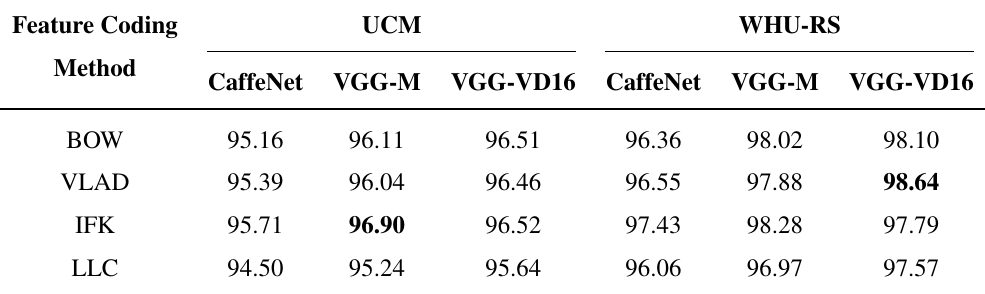
Table 4. Overall Classification Accuracy of Four Feature Coding Methods Using Different Pre-trained